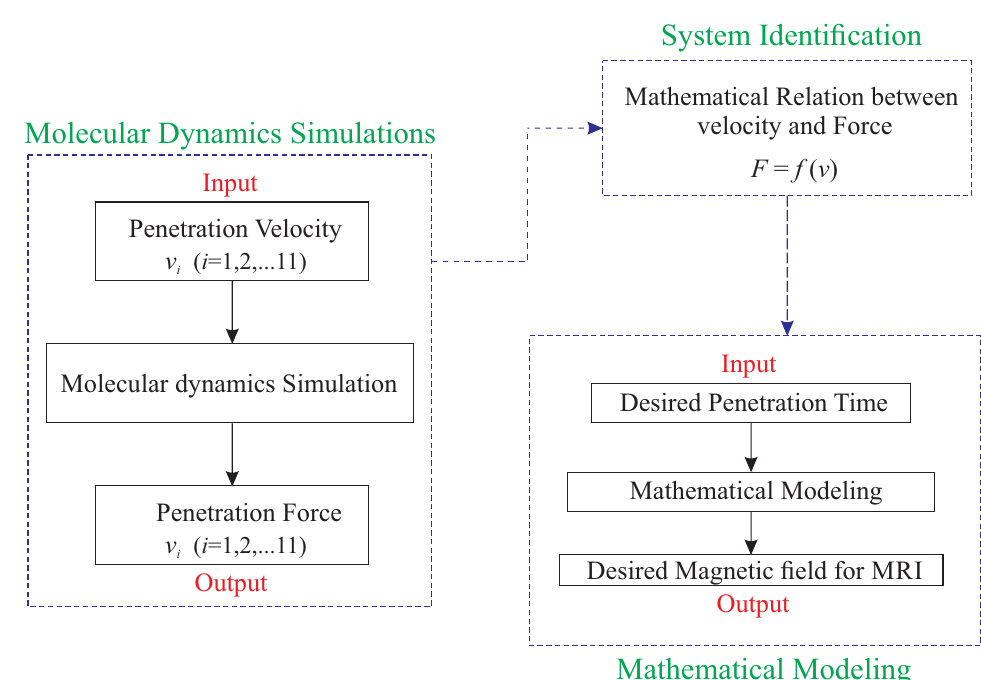
Figure 2. Schematic diagram of methodology of modeling the indentation of the nanocarrier through the membrane using MRI